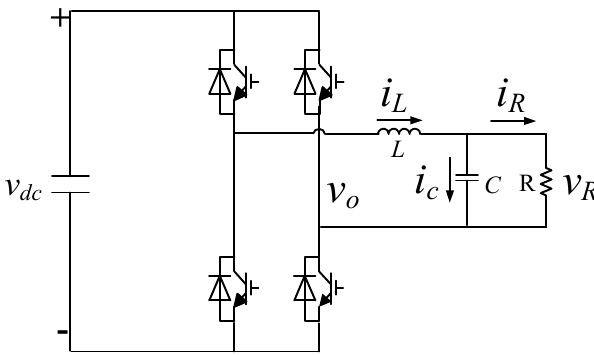
Figure 2. The single-phase DC/AC bidirectional converter works in the inverter state.